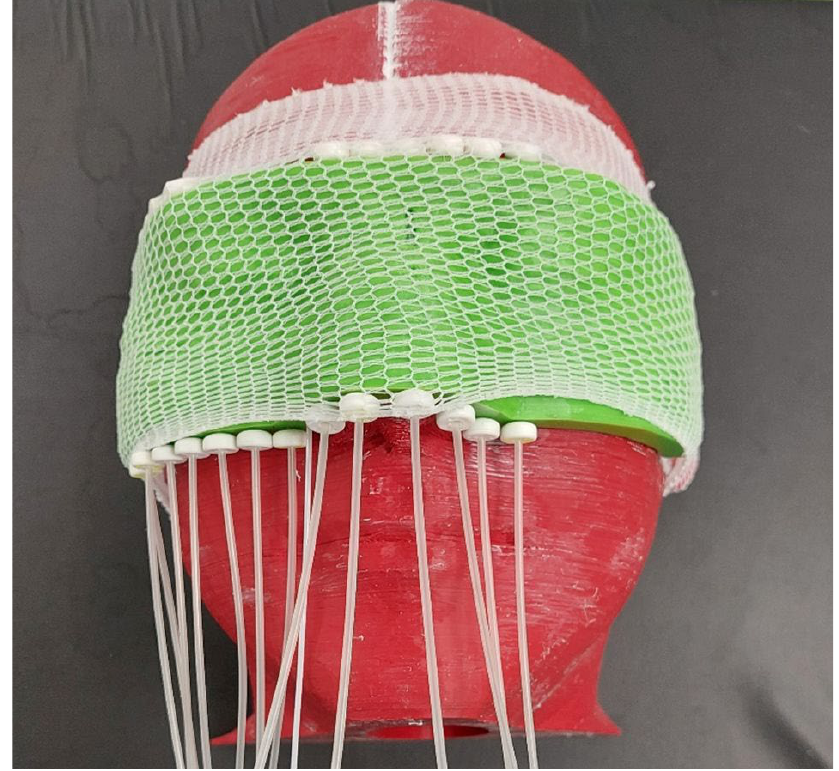
Figure 5. Head phantom with personalized brachytherapy applicator ready for CT imaging.